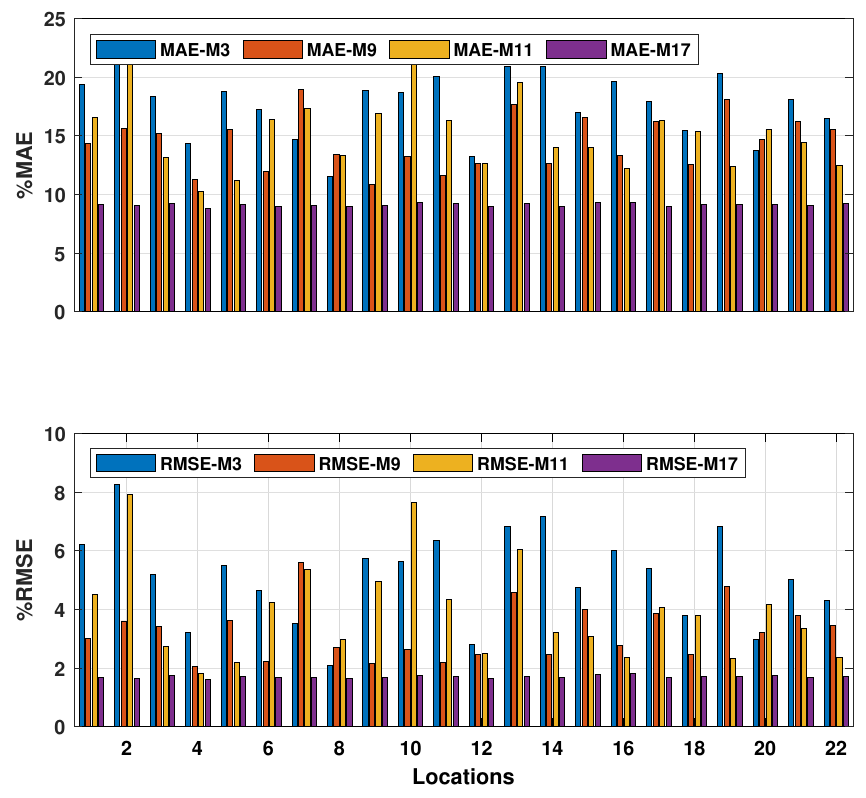
Figure 7. Comparison of the 22 locations of solar plants at 90 min time steps. In Figure 8, all the models were tested with the time series, with the spatiotemporal vector and spatiotemporal input, and the environment is shown in the form of a box plot. The box plot shows the absolute forecast errors of different models. Forecasting error (cid:16) (cid:17) y actual − y predict (FE) = , which is the absolute difference between the actual and predicted value. It seems that the performance ranking of different models according to the median (mean) of the absolute errors was consistent with the previous conclusion. The average deviation for all 22 locations for Model M17 was uniform, which signifies the suitability of Model M17. A narrower range of the error distribution was found with M17 compared to any other model under the CR-CD conditions. Hence, the spatiotemporal input showed a promising result in comparison to the other input types. The red-colored crosses in Figure 8 are outliers. The outliers are those data points that are significantly different from the rest of the dataset. Furthermore, most of the outliers in M9 were smaller than in any other model. Besides, the dispersion of the absolute errors was higher for longer forecast